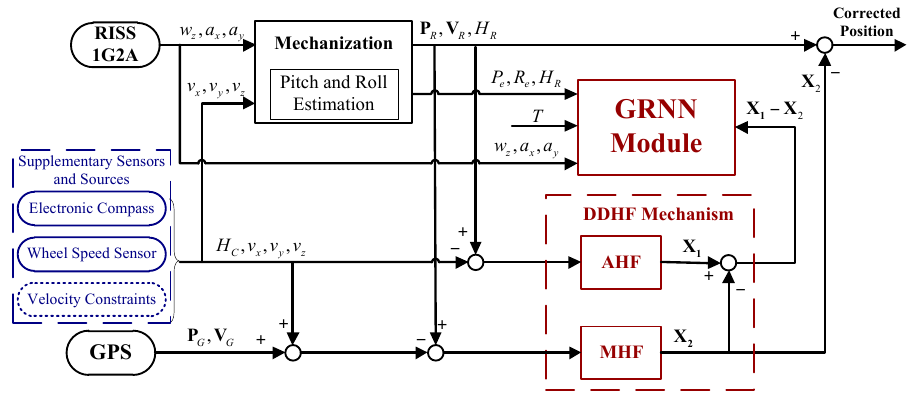
Figure 1. Diagram of the proposed positioning solution (learning mode).